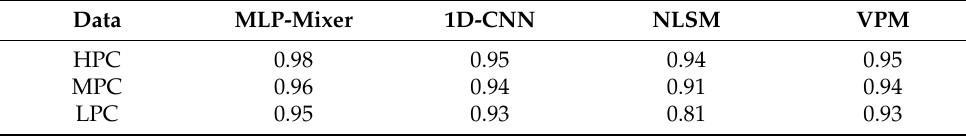
Table 3. SSIM values under different photon counts in Figure 5.